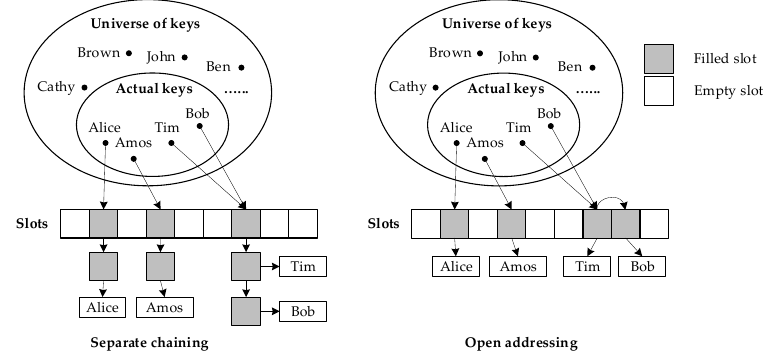
Figure 3. Two main implementations of hash